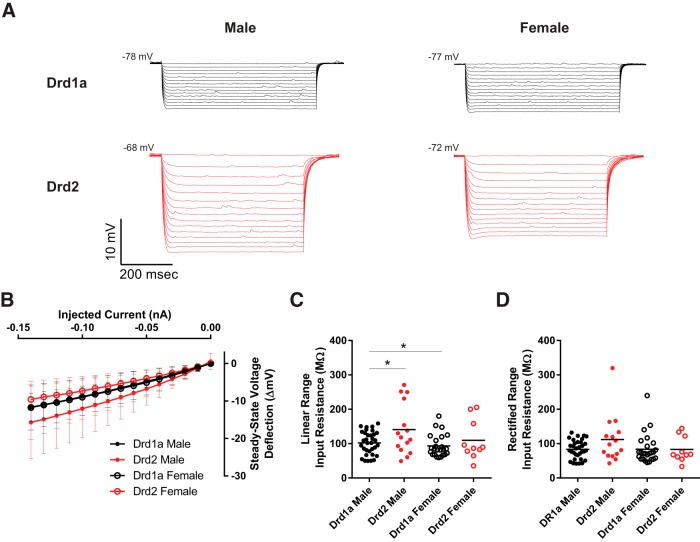
Input resistance varies by MSN subtype. A, Voltage response of male and female Drd1a and Drd2 MSN subtypes to a series of increasingly negative current injections (−0.01 nA current steps). B, Injected negative current to steady-stage voltage deflection curve (I–V curve). Legend, Red solid circles with red line, Drd1a males; black solid circles with black line, Drd2 males; red open circles with red line, Drd1a females; black open circles with black line, Drd2 females. C, Input resistance in the linear range is moderately decreased in Drd1a MSNs compared with Drd2 MSNs. D, Input resistance in the rectified range does not differ between subtypes. *p < 0.05.